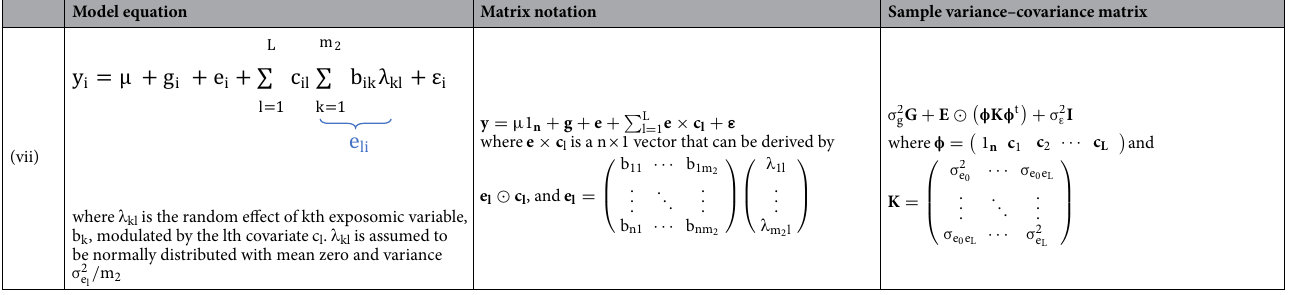
model equation iv of Table 2) is generally free from the estimation bias due to multicollinearity. Note that the largest variance estimate of gxe interactions in this study is ~ 0.09. Validation of exposomic effects. Figure 2a shows the phenotypic prediction accuracy based on genetic data alone. Using fivefold cross-validation, we found that including additive (e) and non-additive effects (exe) of the exposome, which were significant in the discovery dataset, could improve the phenotypic prediction accu- racy in the target dataset. In general, the larger the variance estimates, the greater the prediction improvements (Fig. 2b,c), which indicates that the additive effects of the exposomic variables and exe interactions are genuine. Similarly, we also validated the exposomic effects modulated by specific covariates, by showing that the larger the total variance estimates of exc interactions, the greater the improvement of predication accuracy (Fig. 3). The validated exc interactions would in part explain the phenotypic variance due to residual x covariate interactions found in our previous studies 31–33 .